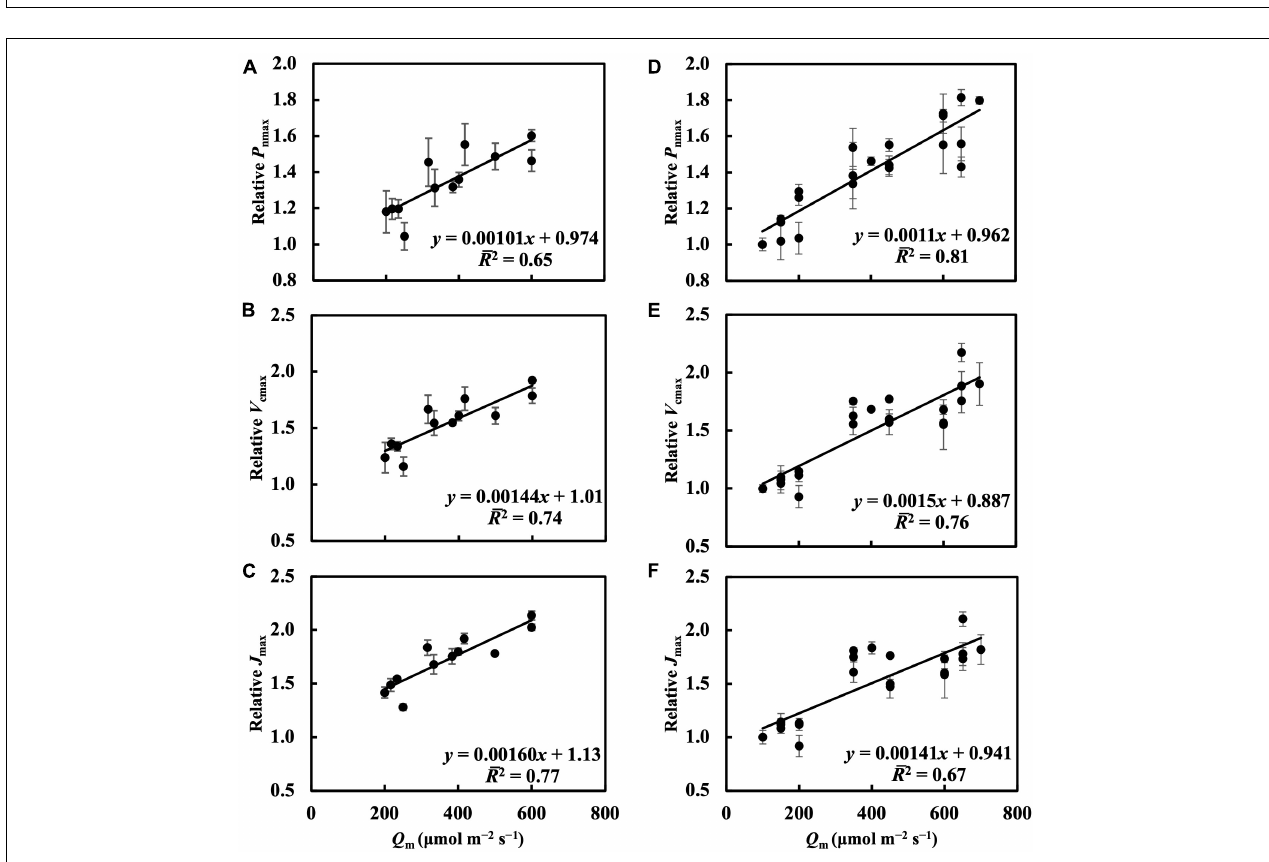
FIGURE 5 | Linear regression of relative P nmax , V cmax , and J max on Q m in the first experiment (A–C) and in the second experiment (D–F) . See section “Treatments” for the details of treatment setting in each experiment. All values were means ± standard errors ( n = 3) and relativized to that for 100 µ mol m − 2 s − 1 . Regression lines, regression functions, and R 2 are